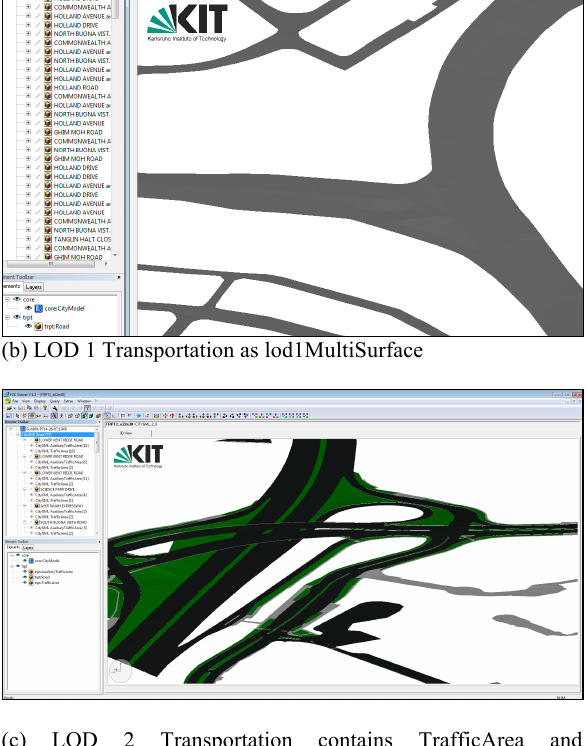
Figure 7. LOD 0 Transportation, LOD 1 Transportation and LOD 2 Transportation.